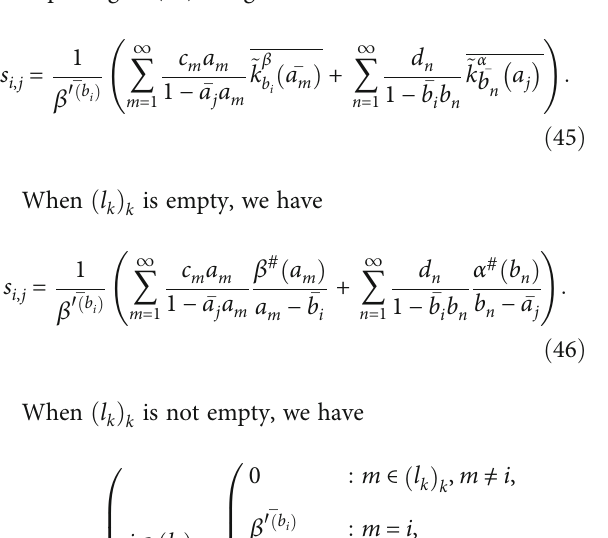
ffiffiffiffiffiffiffiffiffiffiffiffiffiffiffiffi (cid:12) β ′ ζ ð Þ (cid:12) 1 ffiffiffiffiffiffiffiffiffiffiffiffiffiffiffi (cid:12) β ′ ζ ð Þ (cid:12) i ffiffiffiffiffiffiffiffiffiffiffiffiffiffiffi (cid:12) α ′ η ð Þ (cid:12) i ffiffiffiffiffiffiffiffiffiffiffiffiffiffiffiffiffi (cid:3) (cid:4)(cid:12) α ′ η (cid:12) (cid:12) j